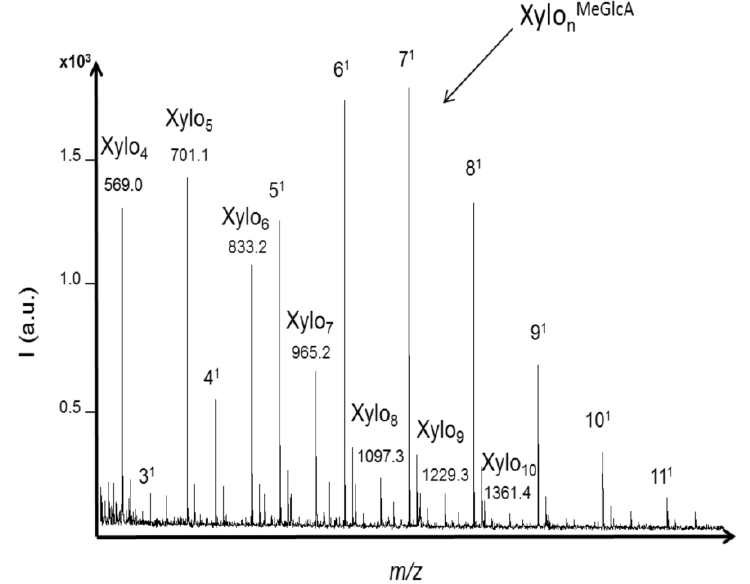
Figure 5. MALDI mass spectra of xylo-oligosaccharides (XOS) produced from xylan hydrolysis by termite hindgut homogenates. Both neutral and acidic XOS were identified based on their m/z values including one sodium adduct. Acidic XOS from three to eleven xylose units carrying one methylglucuronic acid as side chain were detected within the m/z range from 627.1 to